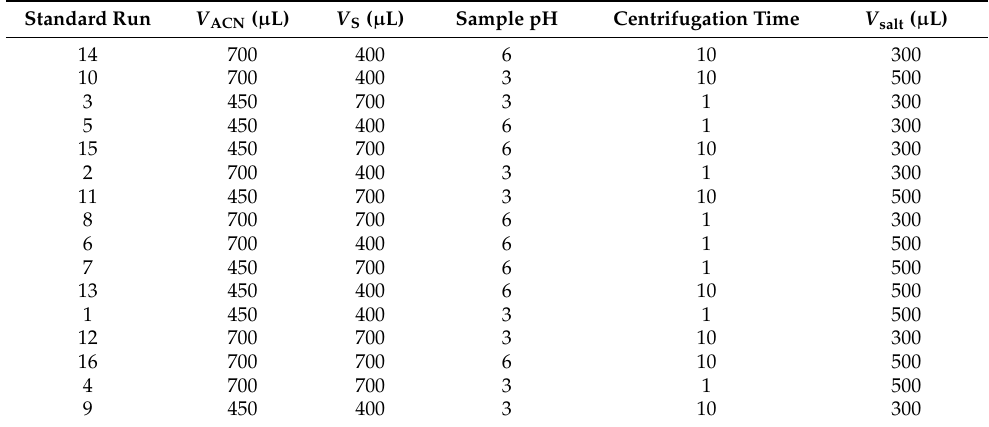
Table 1. Plans of experiments generated by 2-level FFD for the screening of SI-HLLME procedure. Standard